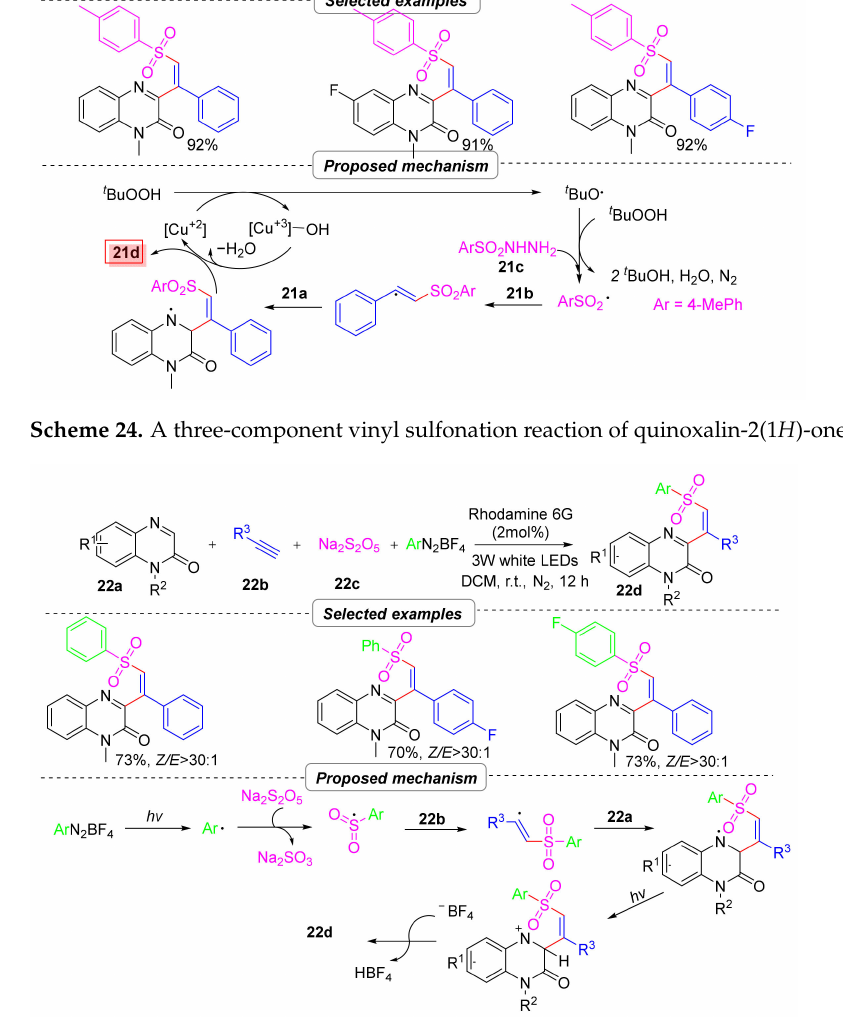
Scheme 25. Visible-light photocatalytic four-component sulfur dioxide insertion